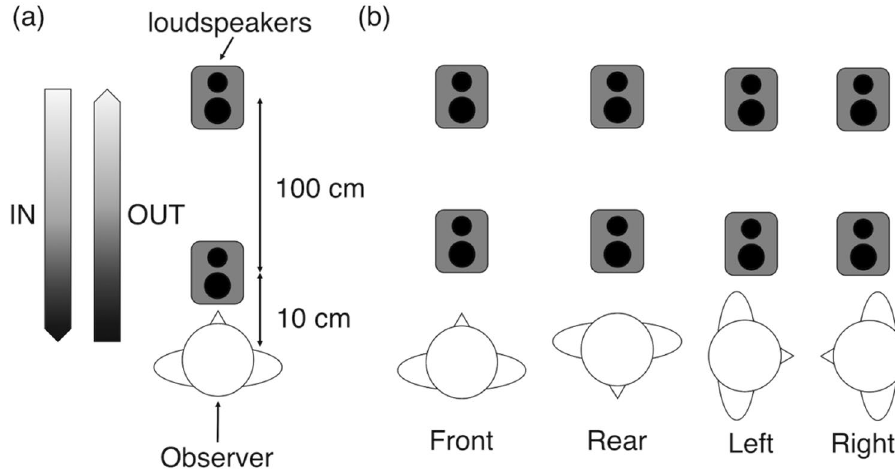
Figure 5. Experimental design. ( a ) Layout of the loudspeakers and observers. ( b ) Direction to the